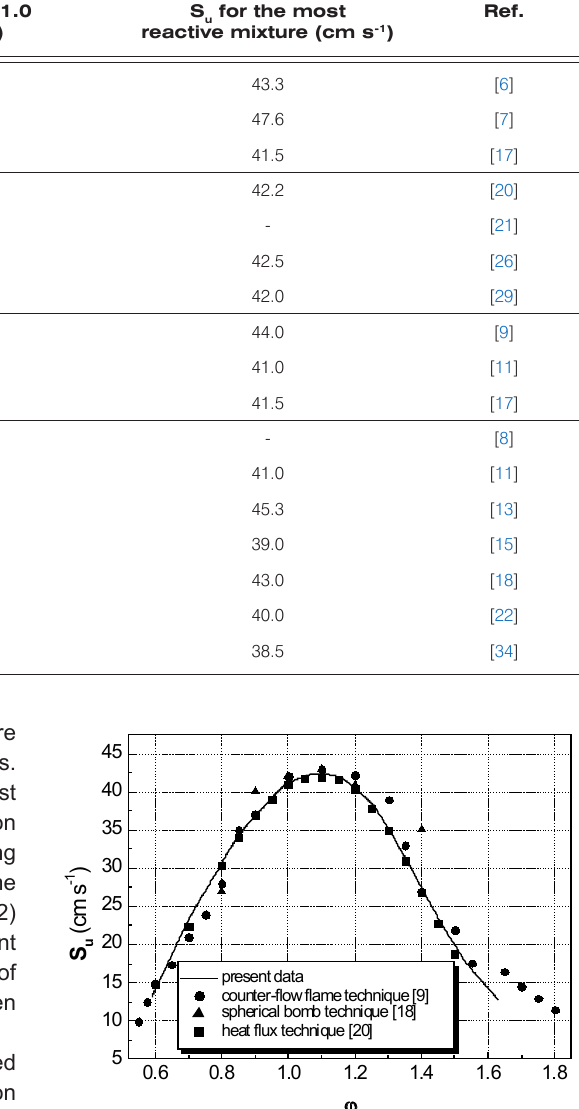
Table 1. Reference values of burning velocity for ethane-air at ambient initial conditions, from various literature sources. Measuring technique Ref.